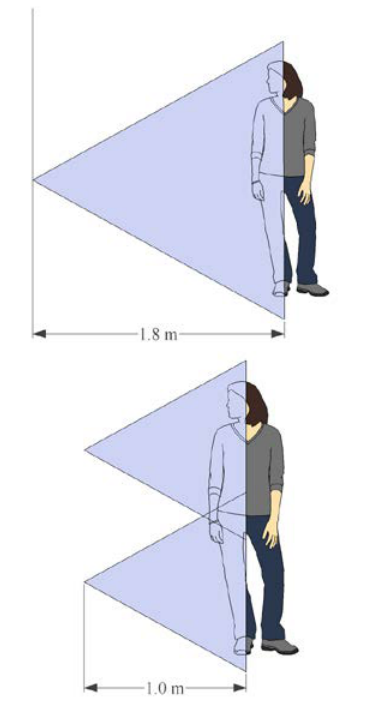
Figure 1. Overview of different products available using PrimeSense’s 3D NUI sensor technology